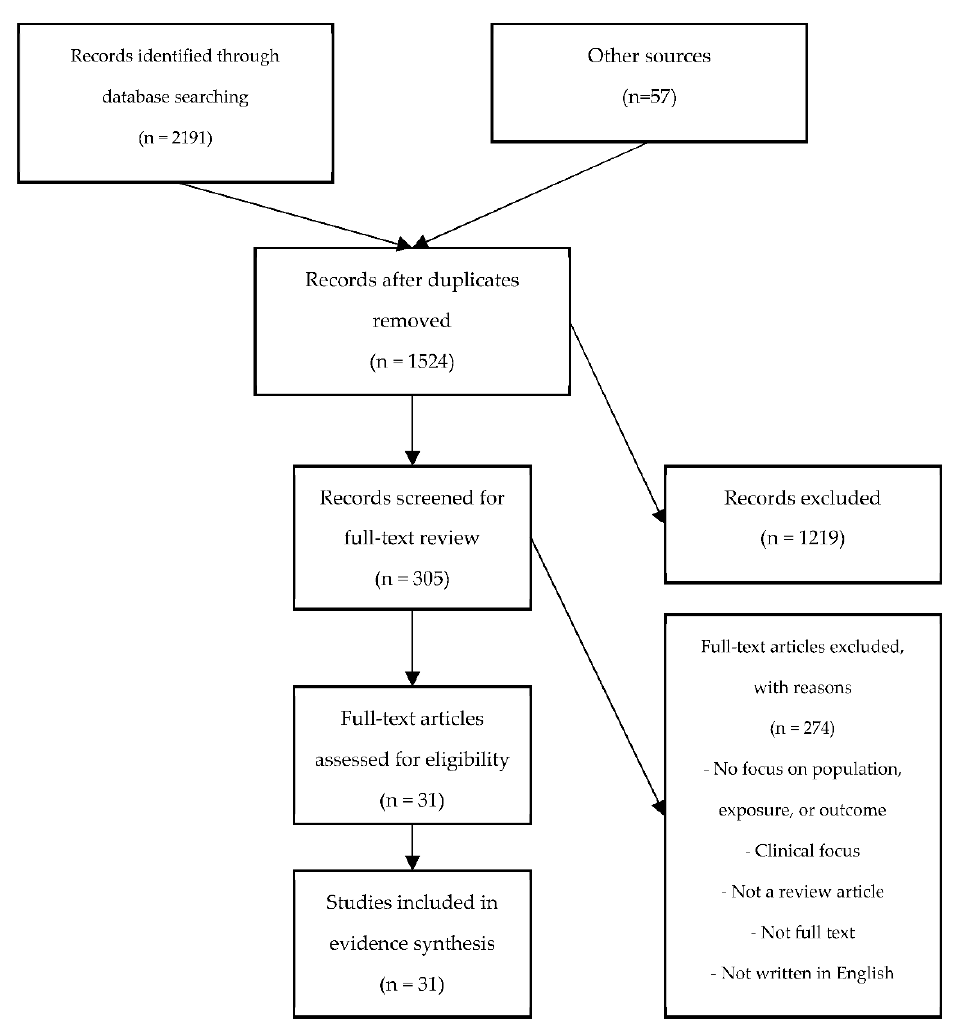
Figure 1. Flow diagram depicting the flow of information through the different phases of the scoping review.